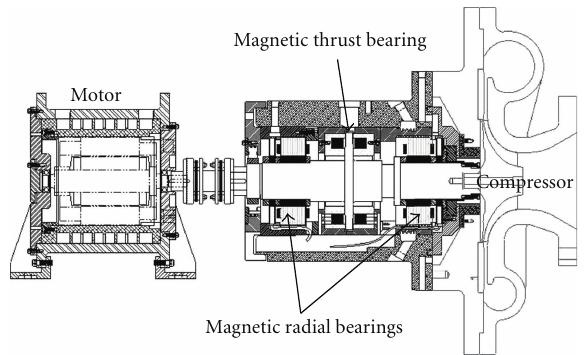
Figure 4: Cross-sectional drawing of test